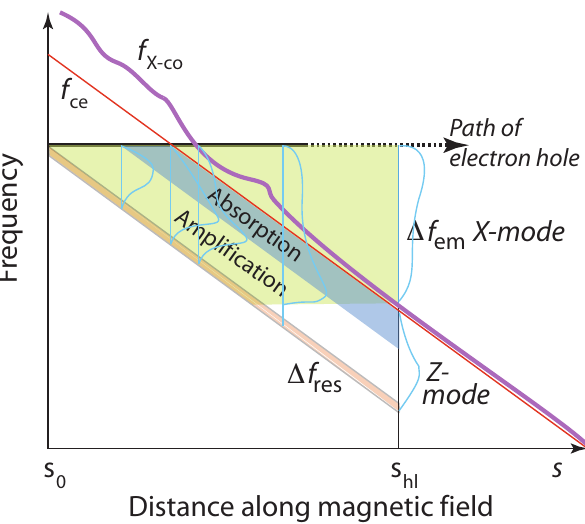
Fig. 8. The evolution of the emission spectrum during passage of the electron hole along the magnetic field from high to low magnetic field strengths (upward). The coordinate s is distance along the magnetic field line, s 0 the start location of the hole. Schematically shown is the variation of the cyclotron frequency f ce = ω ce /ω ce0 ≈ 1 − 3 (s − s 0 )/(R E + s 0 ) in a dipole field, and the X-mode cut-off frequency. The horizontal line is the path of the hole until hole dissolution at location s hl = v h τ h , with τ h the hole life time. The evolution of the emission 1f res , amplification, and absorption ranges is indicated. A wave which was excited at some location s & s 0 by the maser mechanism at a frequency in the nar- row frequency range 1f res will necessarily pass into the amplifica- tion and absorption bands when the hole moves up the field line to lower fields. It will become free, if and after the hole passes the cut-off and subsequently dissolves. The vertical blue cuts show the expected spectra at 4 locations. These are modulated by emission, amplification and absorption. After the hole passed the cut-off fre- quency and resolves, the final emission is released in the X mode over the bandwidth 1f em . In case the hole resolves before passing the cut-off, the radiation will be in the Z-mode and will be trapped in the downward current region plasma save passing the boundary to the upward current region where it transforms into the